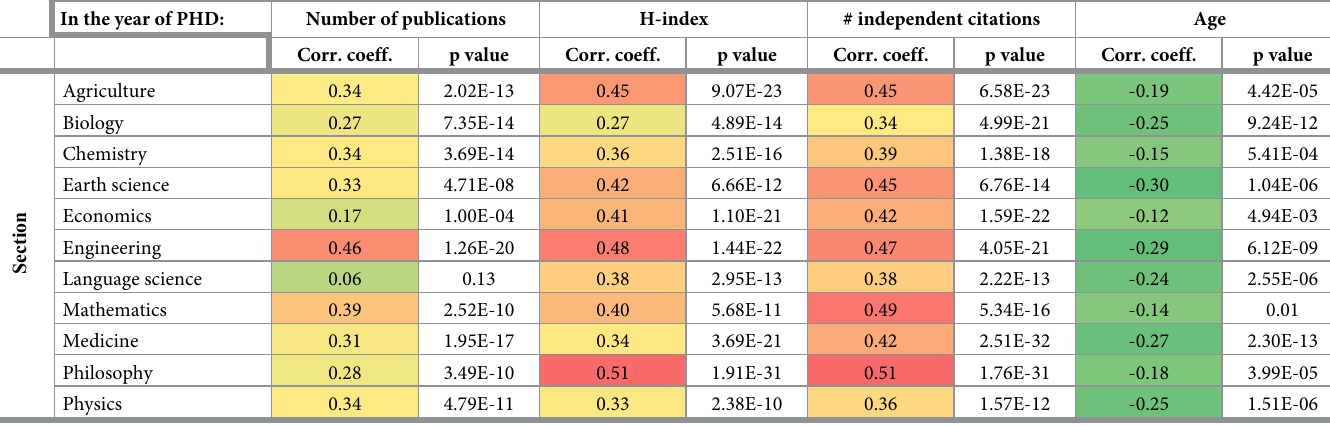
Table 3. Correlation between the number of citations in the tenth year after obtaining the PhD. In the year of